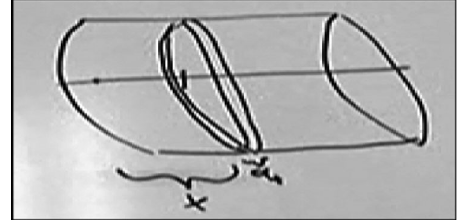
FIG. 15. David’s gesture about ‘‘separating into